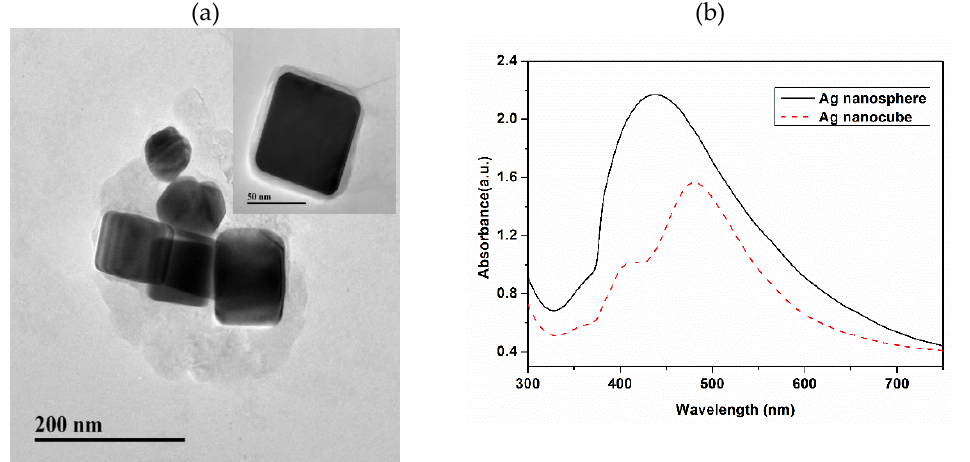
Figure 2. (a) AgNCs TEM image and (b) UV-Vis absorbance spectrum of AgNCs and nanosphere.